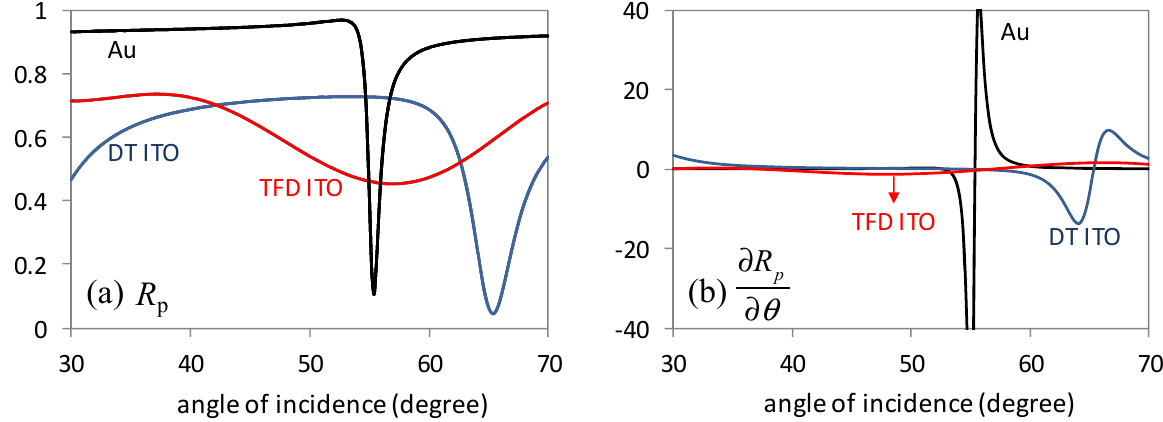
Figure 6. ( a ) Simulated reflectivity of p-polarized light from NLO samples containing gold (black), DT (blue), or TFD (red) ITO at the wavelength of 1,550 nm. 1.73 and 1.75 were used for no and ne of NLOP, respectively and the NLOP film thickness was assumed to be 4 μ m; ( b ) Simulated derivative of reflectivity data as a function of angle of